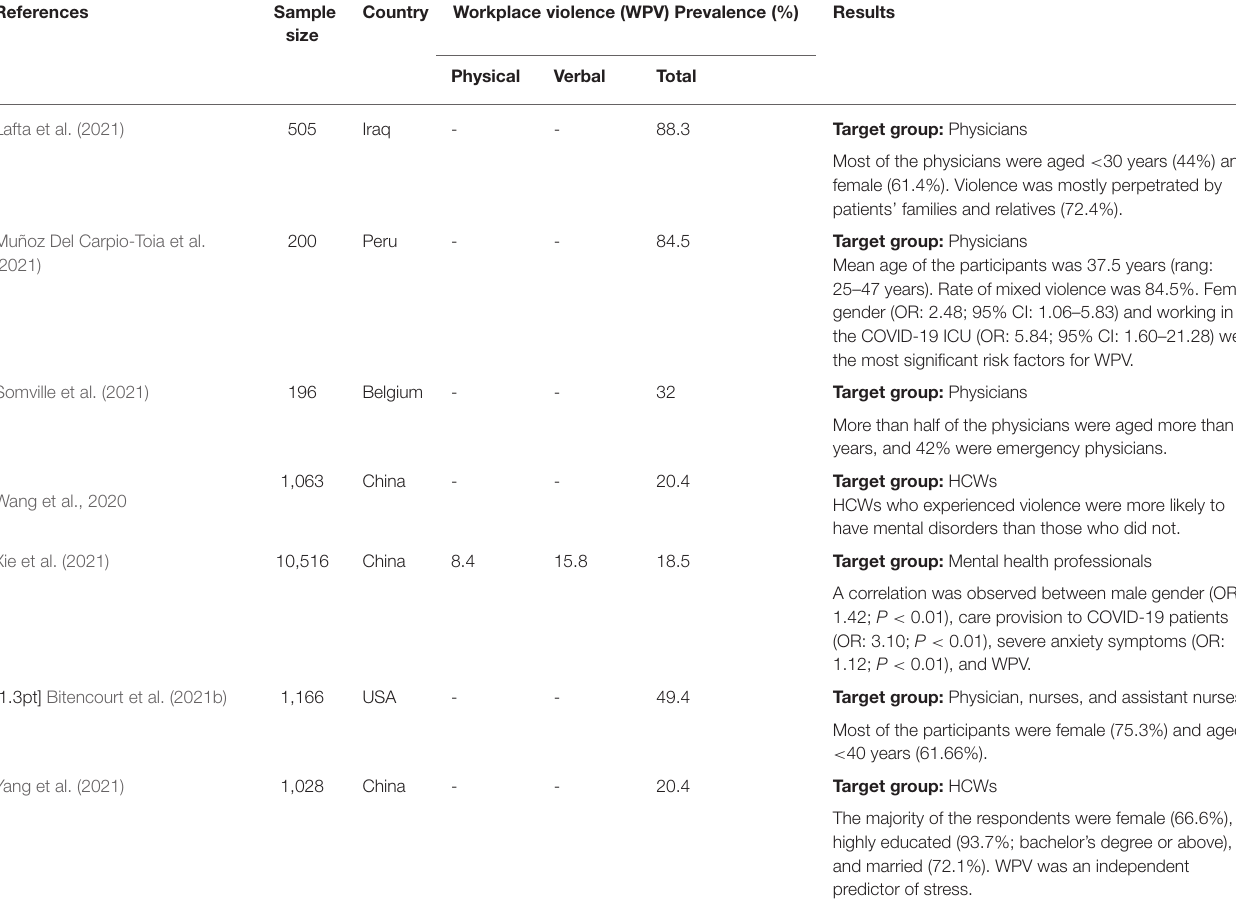
88.3 Target group: Physicians Most of the physicians were aged < 30 years (44%) and female (61.4%). Violence was mostly perpetrated by patients’ families and relatives (72.4%). 84.5 Target group: Physicians Mean age of the participants was 37.5 years (rang: 25–47 years). Rate of mixed violence was 84.5%. Female gender (OR: 2.48; 95% CI: 1.06–5.83) and working in